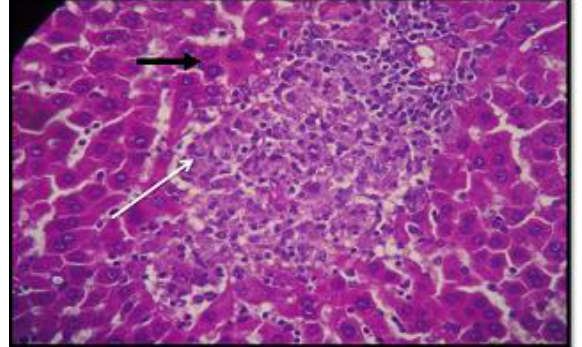
Figure,8: Photomicrographs showing histology of liver tissue from group T2 showed focal MNCs periductal aggregation consistmainly of macrophage with slight kupffer cells proliferation ( H - E X 40).